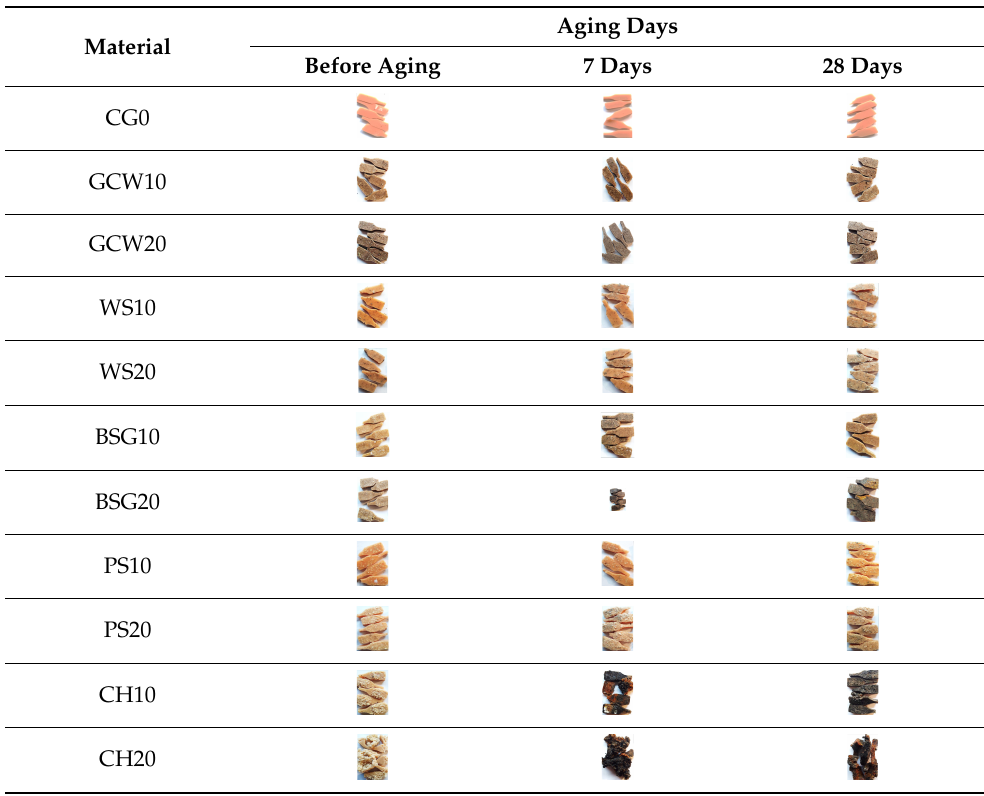
Table 5. Accelerated aging effect on the obtained